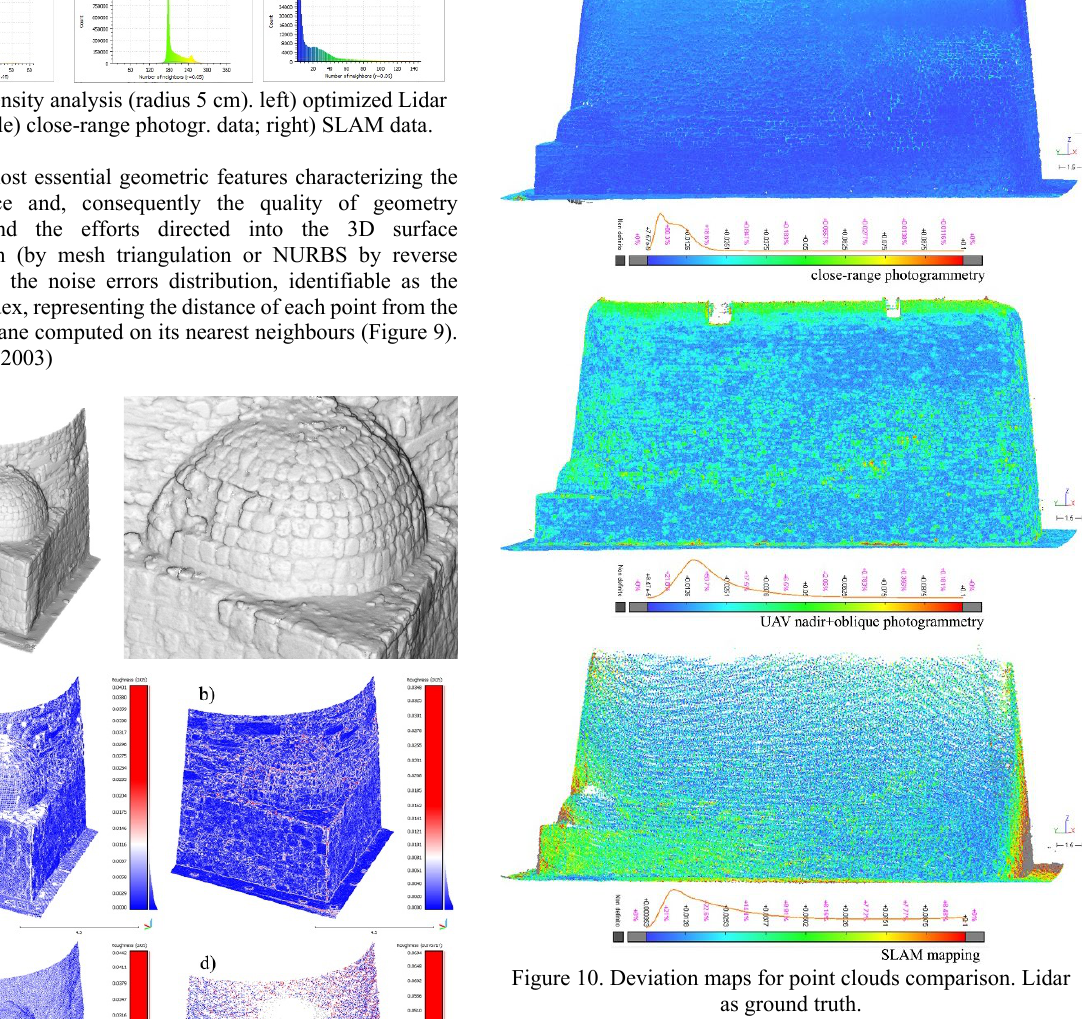
Figure 9. The indication of the bastion corner detail in the close- range photogrammetric points surface. The roughness analysis (radius 5 cm). a) optimized Lidar; b) close-range photogrammetry; c) UAV photogrammetry; d) SLAM. The histogram curve amplitude tended toward red points indicates a large and distributed roughness in the SLAM point cloud in d) and, at the opposite, in b) the noise errors concentrated